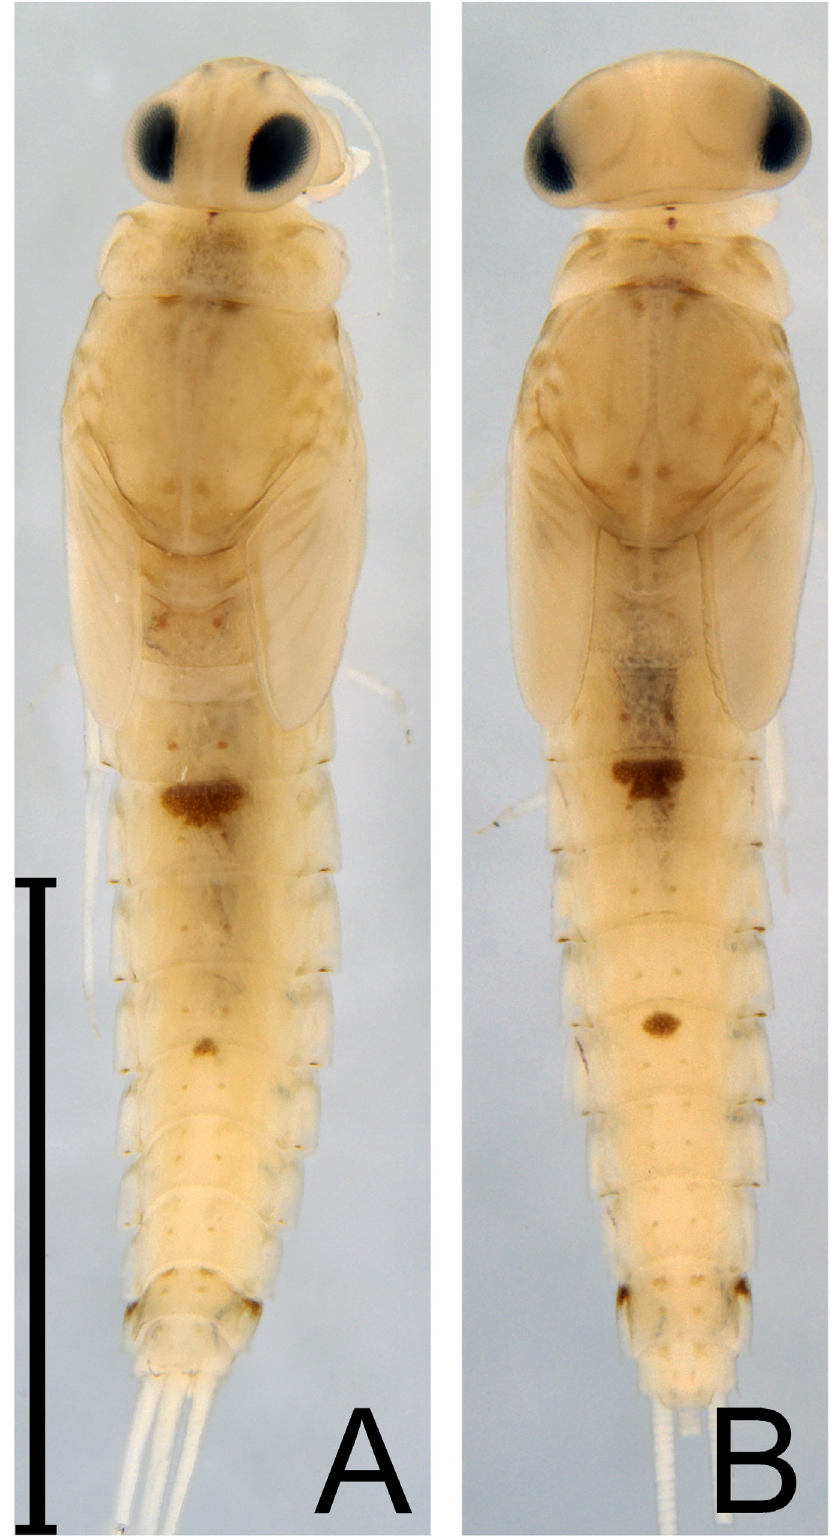
Fig. 15. Rivudiva uiara sp. nov. A . Dorsal habitus of female nymph, holotype (INPA). B . Dorsal habitus of male nymph, paratype (INPA). Scale bar = 1.65